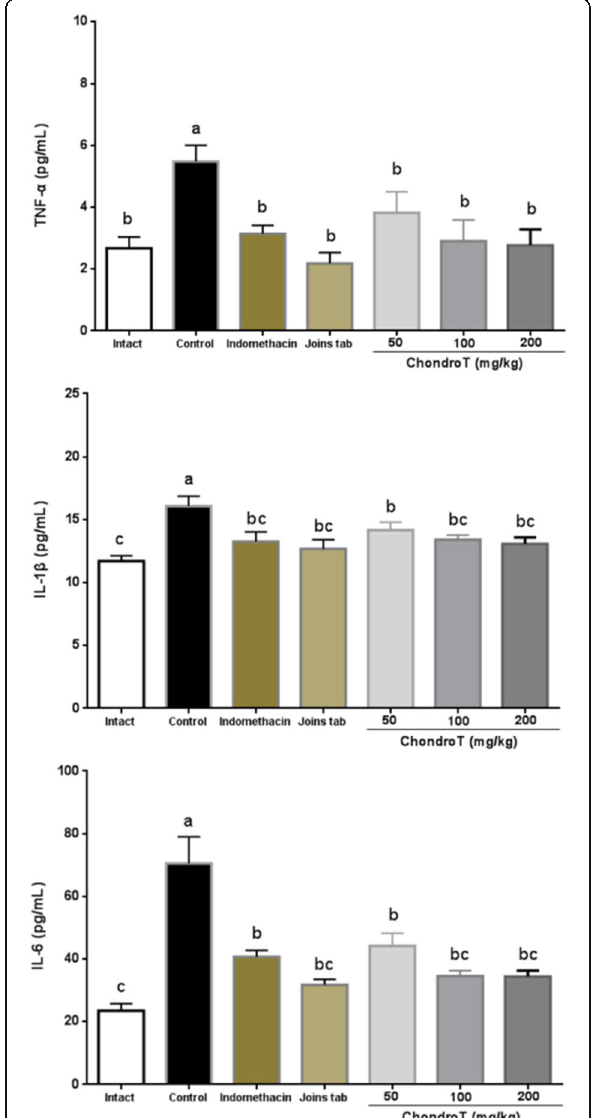
Fig. 2 Effect of ChondroT on TNF- α , IL-1 β , and IL-6 levels in rats with collagenase -induced